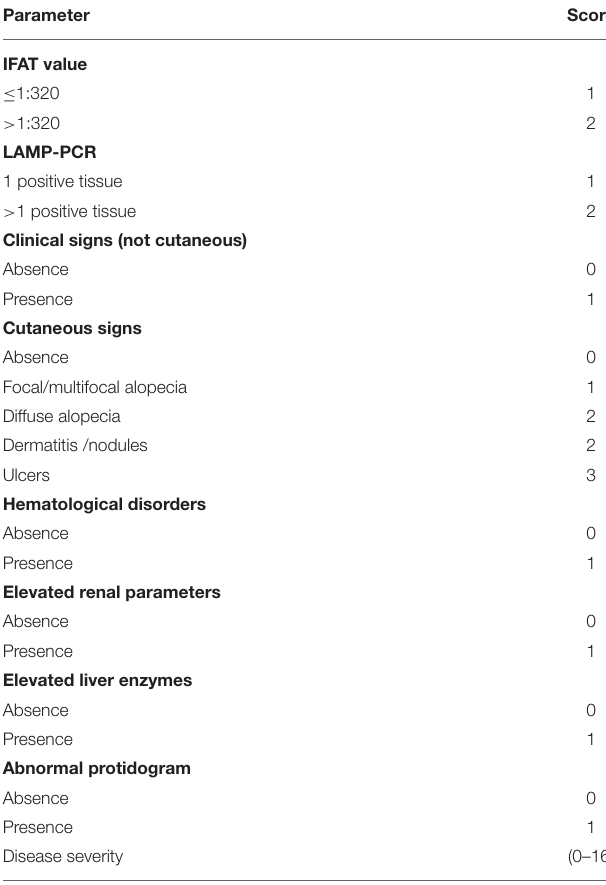
TABLE 1 | Clinical and parasitological parameters to assess the disease severity score.